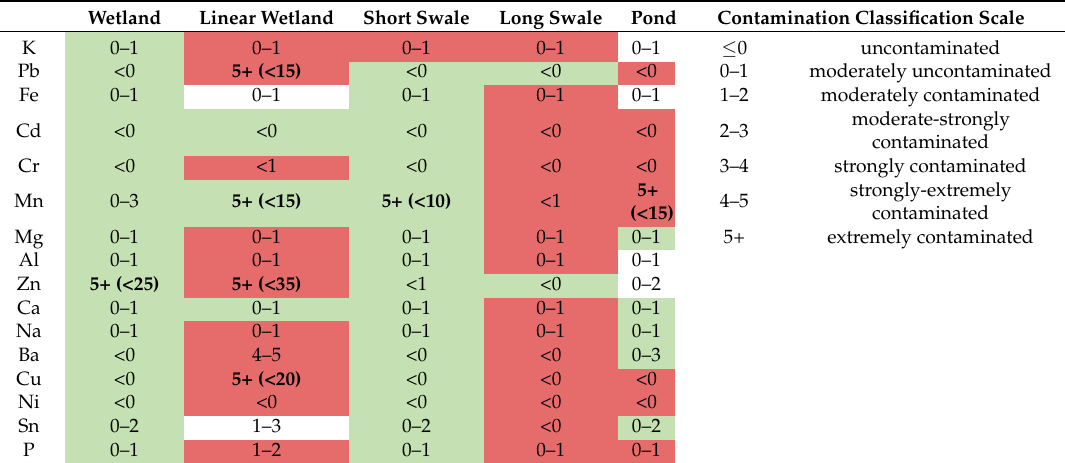
Table 9. Igeo values and trend summary for monitored SuDS